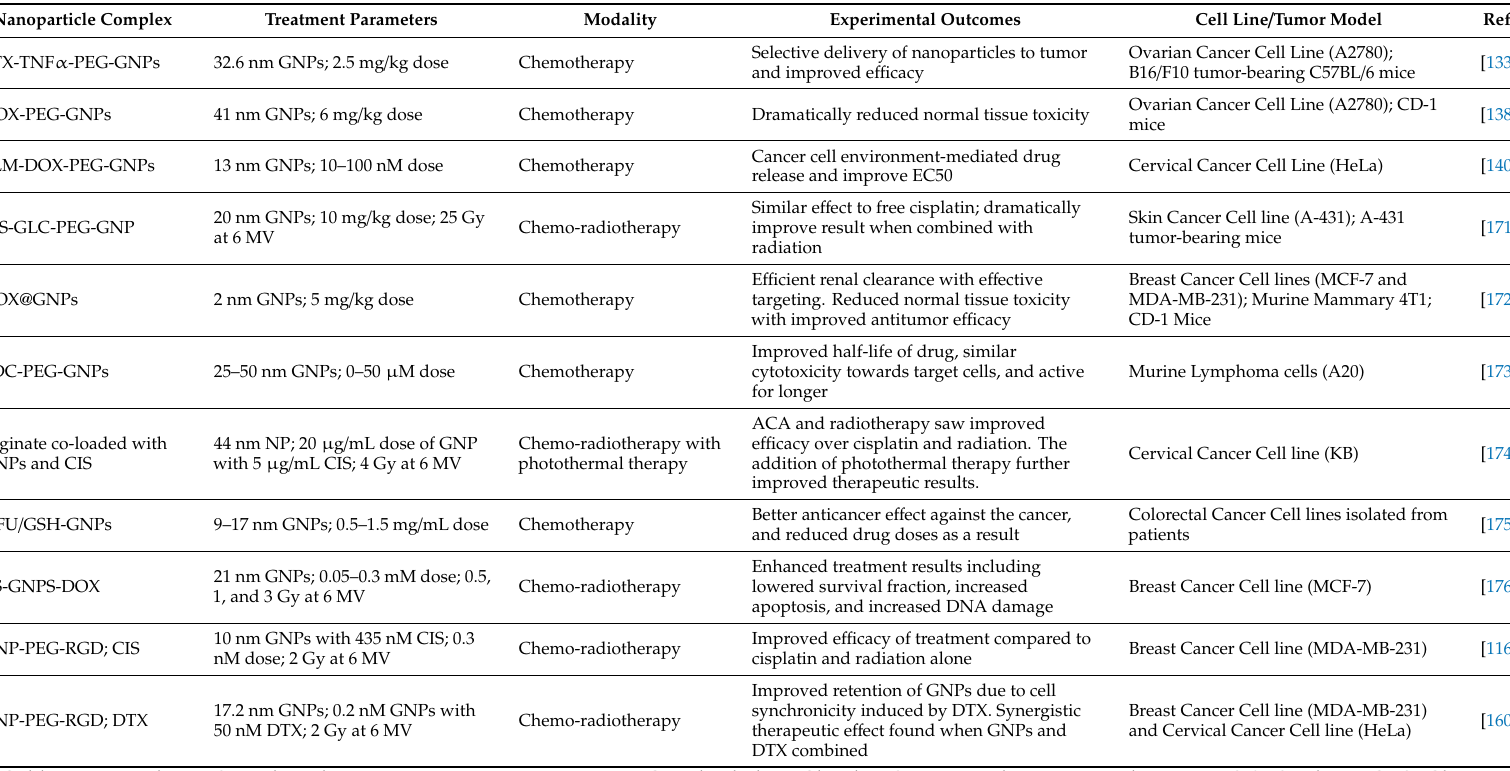
Table 1. Recent applications of anticancer drugs with gold nanoparticles in drug delivery and combined radiation therapy with clinically relevant energies. Nanoparticle